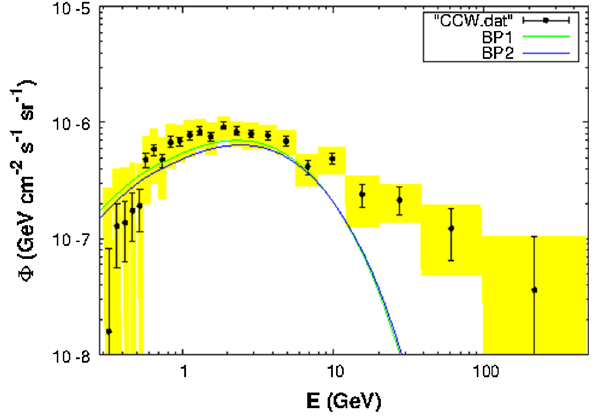
Fig. 5 Comparison of the Fermi-LAT excess results from CCW [60] with the gamma ray flux obtained from benchmark points tabulated